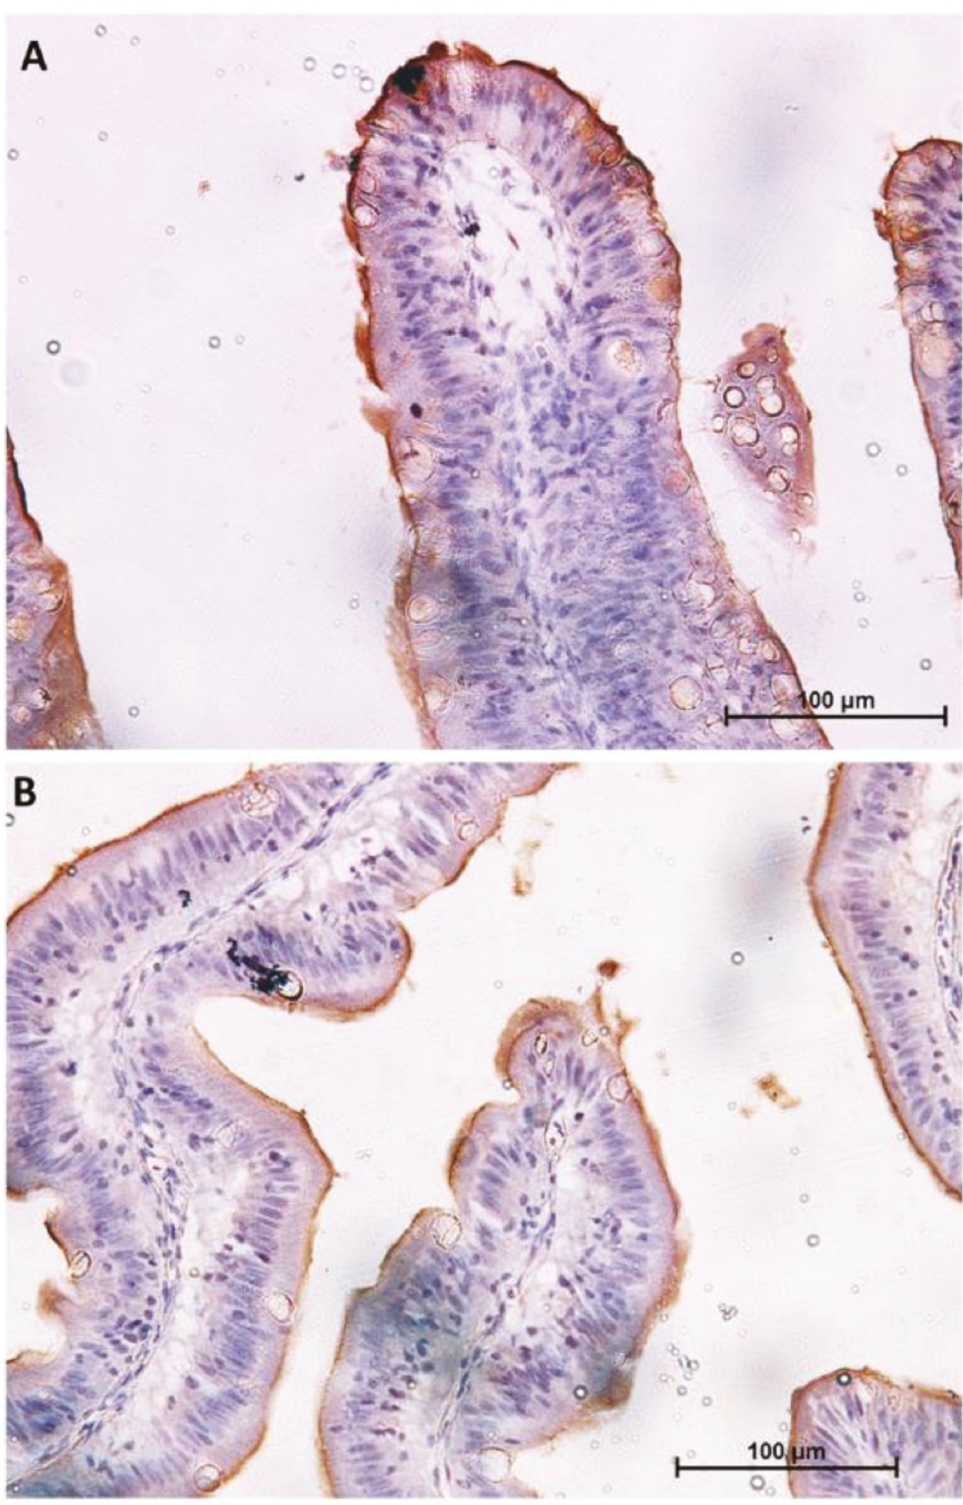
Figure 4. Immunolocalization of sodium–glucose / galactose transporter 1 (SGLT1) in the first segment of the mid-intestine ( A ) and in the pyloric caeca ( B ). The signal is limited to the enterocyte brush border.